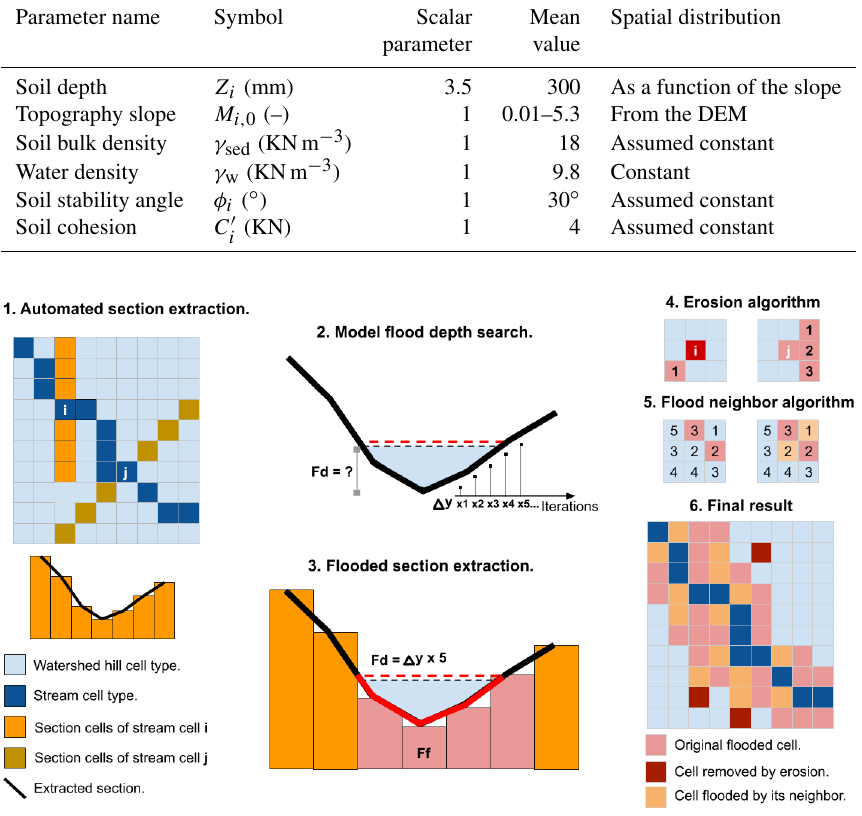
Figure 8. Illustrative diagram of the HydroFlash submodel scheme. Step 1: the submodel extracts the cross profile from the network con- sidering the DEM and flow direction. Step 2: based on Eq. (21), the submodel obtains the first approximation of the flash flood streamflow; then, the flood depth and the cross-sectional area are obtained from Eqs. (22) to (21). Step 3: the submodel obtains the flooded portion of the cross section. Step 4: erosion post-process. Step 5: filling post-process. Step 6: the final result for a time step t .